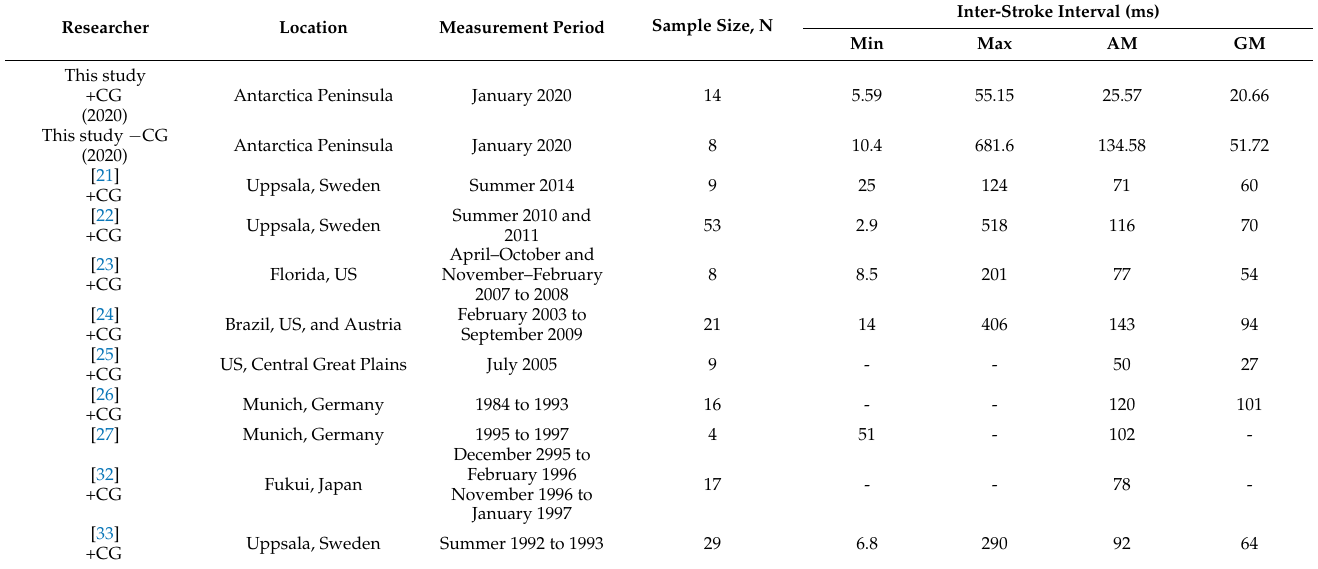
Table A5. Inter-stroke intervals comparison between previous studies.